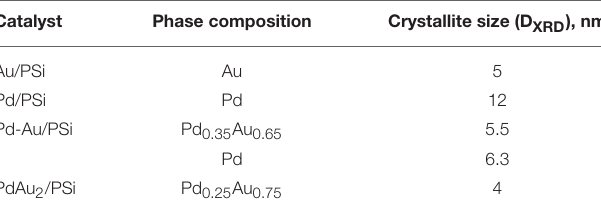
TABLE 2 | Catalysts phase composition, relating to Figure 3